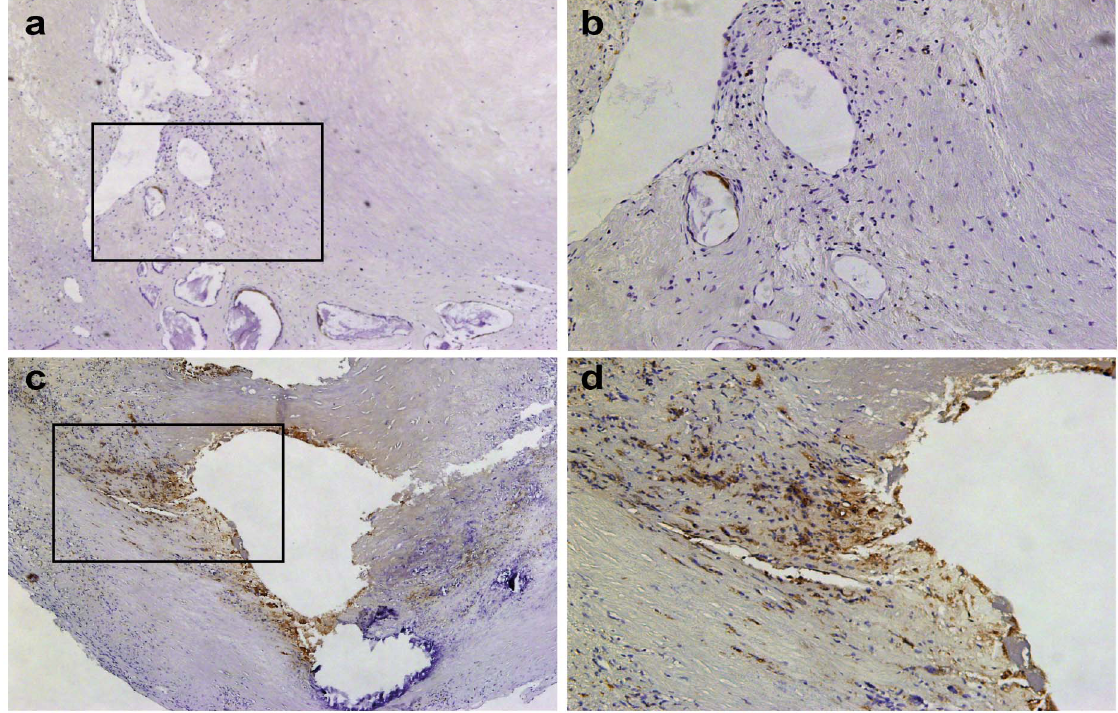
Figure 4. Histology of macrophage levels in atherosclerotic carotid plaques. Macrophage staining (brown), nucleus staining with haematoxylin (blue). ( a ) Low macrophage levels (40 6 magnification). ( b ) Higher magnification of the indicated area in (a) (100 6 magnification). ( c ) High macrophage levels (40 6 magnification). ( d ) Higher magnification of the indicated area in (c) (100 6 magnification).